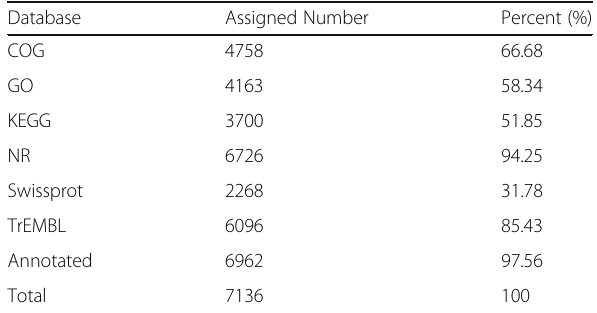
genes participate in nitrogen biosynthesis and degradation (Additional file 3: Table S3). Three genes, nif K, nif D